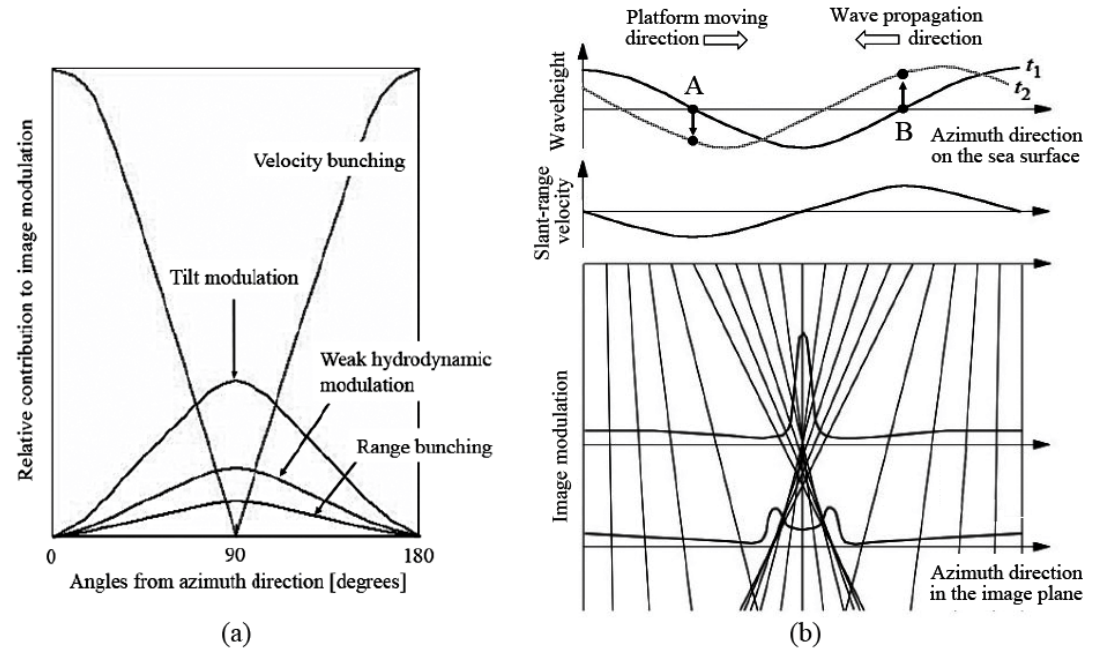
Figure 4. ( a ) Relative contribution to ocean wave image modulation in terms of the azimuth angle. ( b ) Illustration of the non–linear image modulation by velocity bunching.